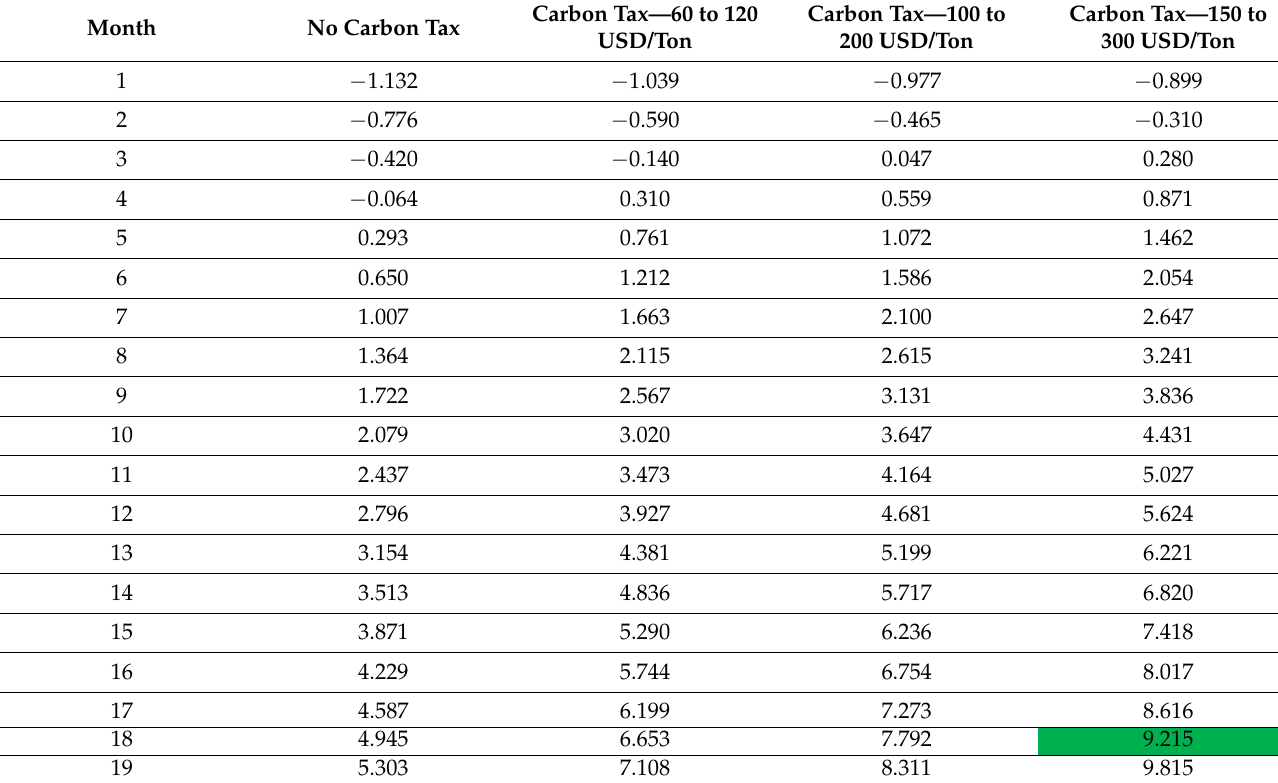
Figure 15. Differences in electricity expenditure in a reference cement plant, with and without WHR captive plant, under different carbon tax scenarios. Table 2. Quantitative simulation results of the first 31 time-steps calculating the differences in electricity expenditure, with and without WHR captive plant, under different carbon tax